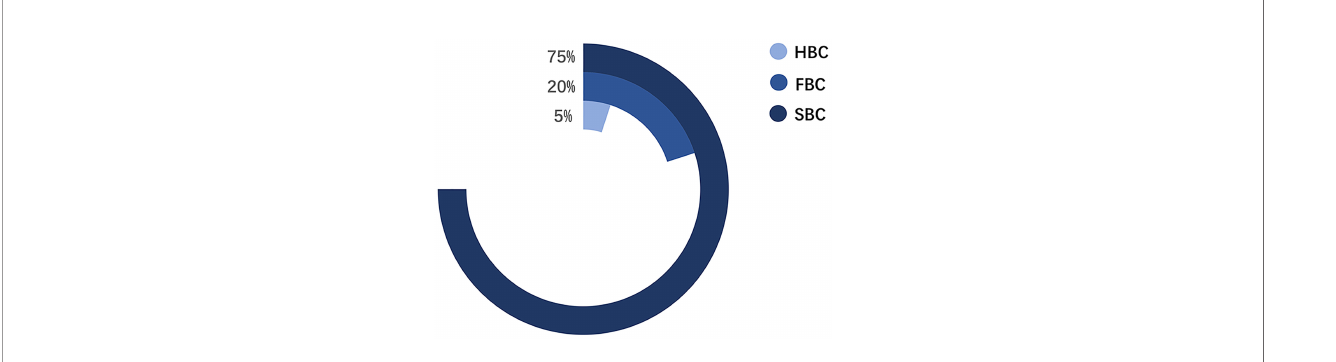
FIGURE 2 | The proportion of three categories